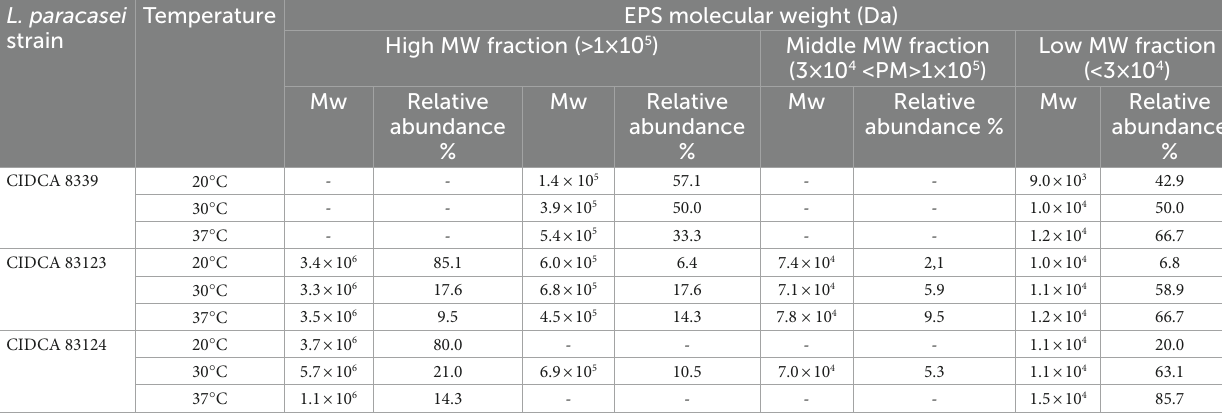
TABLE 2 Molecular weight and relative abundance (percentual expression) of EPS fractions produced by L paracasei strains in milk at different temperatures. L. paracasei